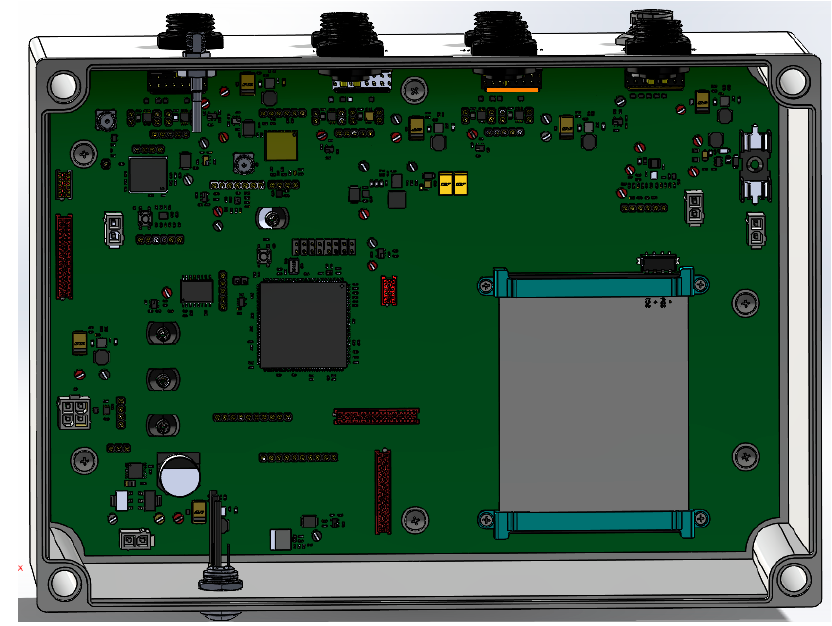
Figure 10. Smart Data Logger top view with the cover Figure 10 . Smart Data Logger top view with the cover open.